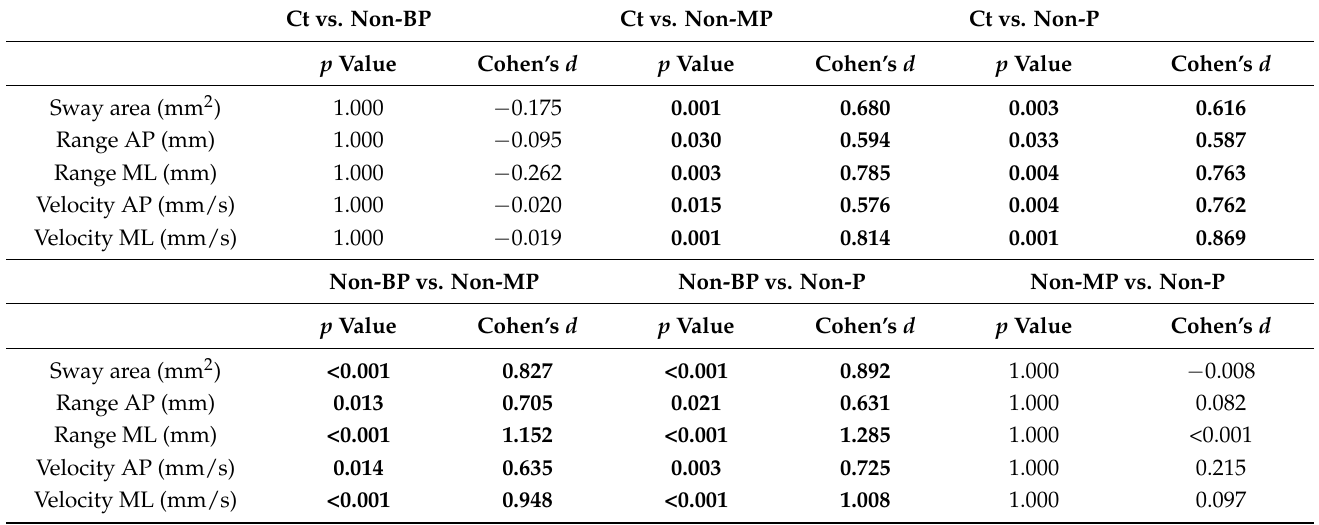
Table 2. Results of post-hoc